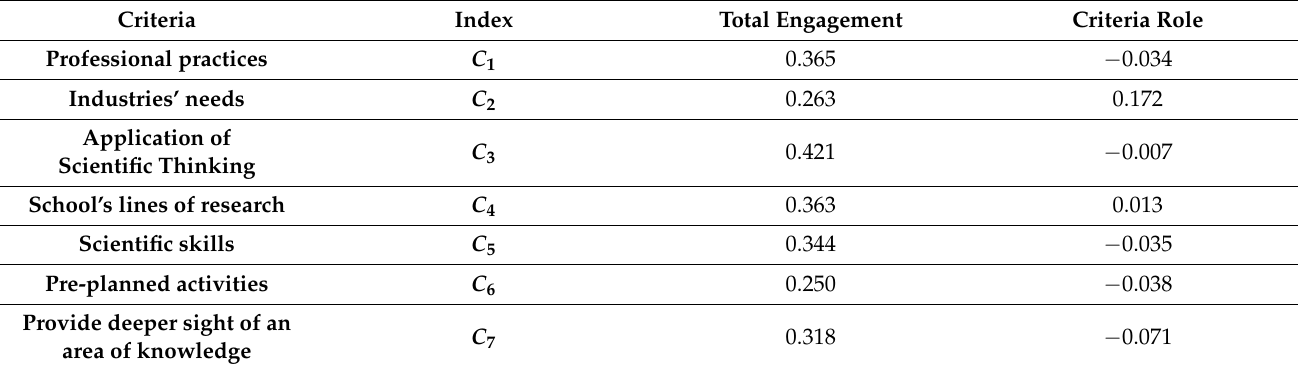
Table 10. Experiment 1 results.